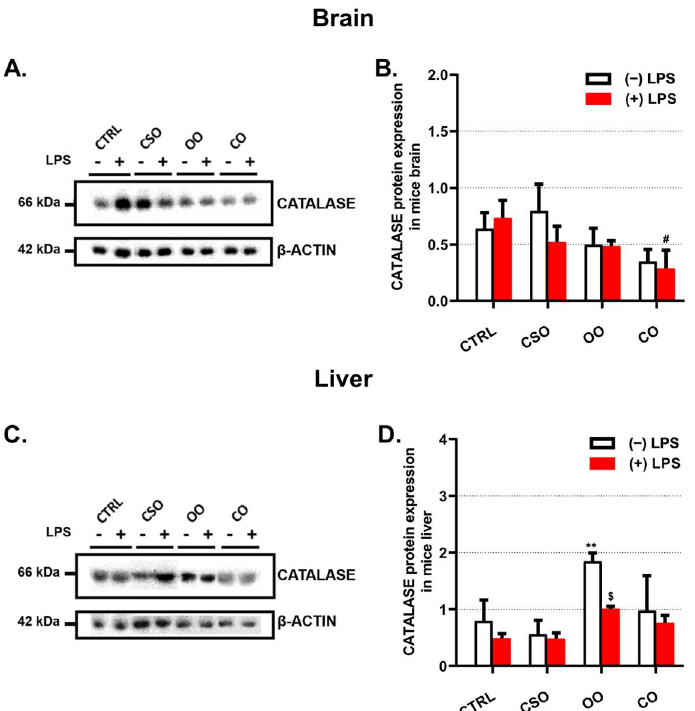
Figure 6. Effect of cactus seed oil, olive oil, or colza oil treatment on the expression of peroxisomal CAT in brain ( A ) and in liver ( C ). Male C57BL/6 mice received for 28 days a standard diet (control (CTRL)), a diet enriched with 6% ( w / w ) CSO, OO, or CO, and intravenous injection of LPS (100 µg) four hours antemortem. Brain and liver homogenates were separated in PAGE-SDS electrophoresis and subjected to immunoblotting as described in Material and Methods section. Immunoblots were performed in triplicate and here we showed a representative blot. The CAT 66 kDa band intensities were analyzed by densitometry and standardized to β-actine (42 kDa) expression level in brain ( B ) and in liver ( D ). All values are means ± SD (n = 3) of 6 independent replicates for CTRL, LPS, CSO, and CSO+LPS, and 3 replicates for OO, OO+LPS, CO, and CO+LPS; statistical significance of higher mean signal strength (*** p ≤ 0.001. ** p ≤ 0.01) compared to control, (# p ≤ 0.05) compared to LPS, and ($ p ≤ 0.05) compared to the different treatments with or without LPS administration. Statistics were executed using two-way ANOVA followed by Tukey test for multiple comparisons.